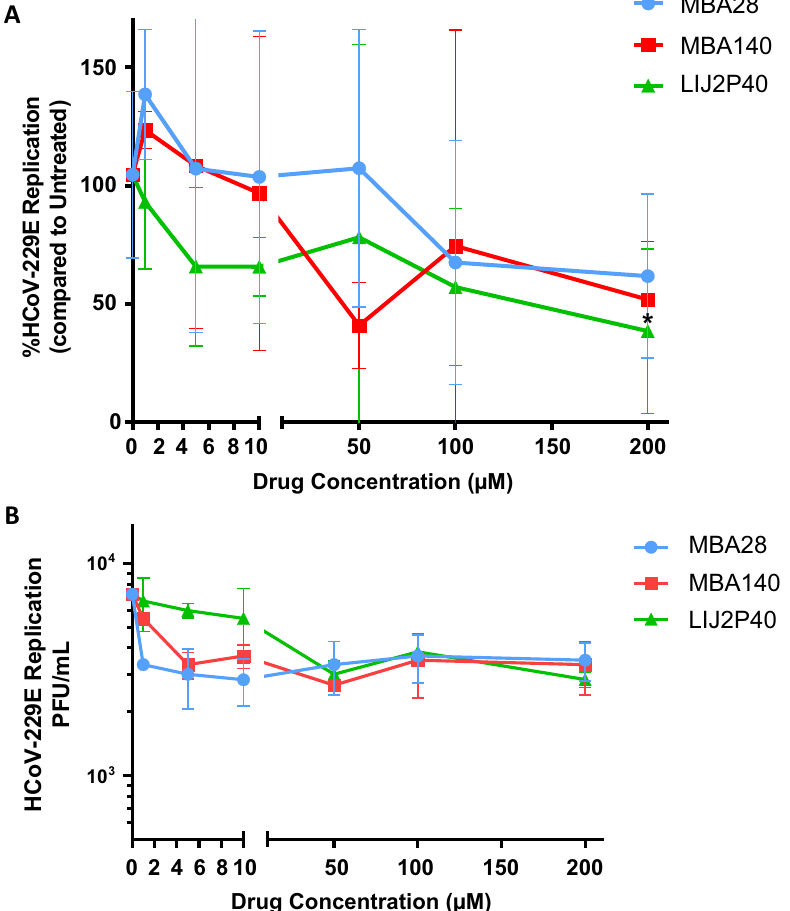
Figure 2. Inhibition of replication of high HCoV-229E viral load measured by RT-qPCR ( A ) and PFU assay ( B ) on MRC5 cells by LIJ2P40, MBA140 and MBA28. Cells were treated by compounds at the time of infection with HCoV-229E (MOI = 1). PFU assay and RT-qPCR were performed after 48 h. Untreated cells infected with HCoV-229E (864.10 4 copies/mL) were used for normalization. RT-qPCR results are represented as mean ± SD of three independent experiments done in duplicates. PFU assay results are represented as mean ± SD of a single experiment done in triplicates. The Wilcoxon signed-rank test (value of 100) was used as statistical test with P ≤ 0.05 =